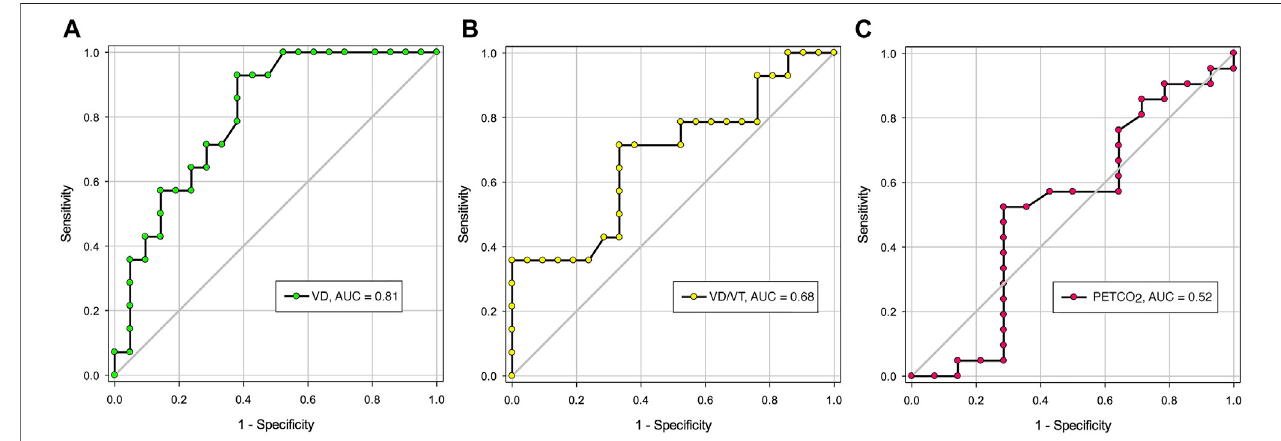
FIGURE 1 | The area under the Receiver Operating Characteristic Curves for resting VD, VD/VT and PETCO 2 . (A) . Area under the curve (AUC) for VD: 0.81 ( p = 002); (B) . AUC for VD/VT: 0.68 ( p = 0.077); (C) . AUC for PETCO 2 : 0.52 ( p = 0.839). De fi nition of abbreviations: VD, dead space volume; VD/VT, dead space to tidal volume ratio; PETCO 2 , end-tidal CO 2 pressure. NS, not signi fi